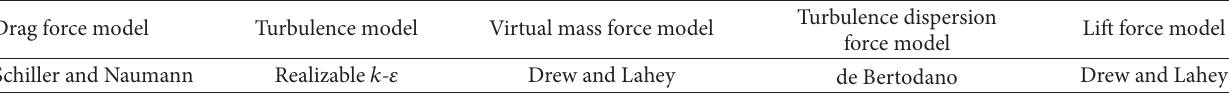
Table 1: Summary of parameters in the two-fluid model.